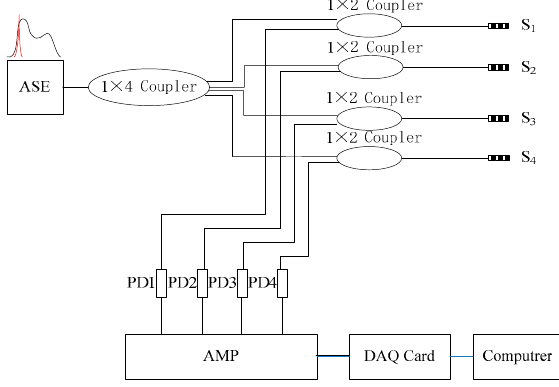
Figure 3. Wave velocities measurement system.